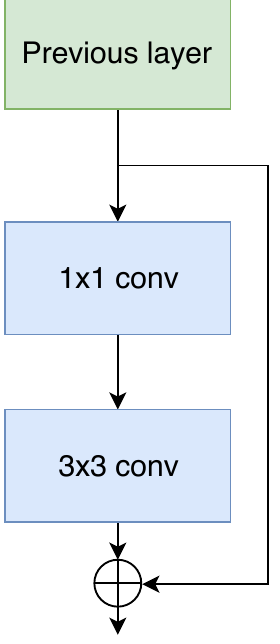
Figure 7. Diagram of the residual module. The number of filters for the 1 × 1 layer and the 3 × 3 layer is the same, e.g., 64 for the top residual module appearing in Figure